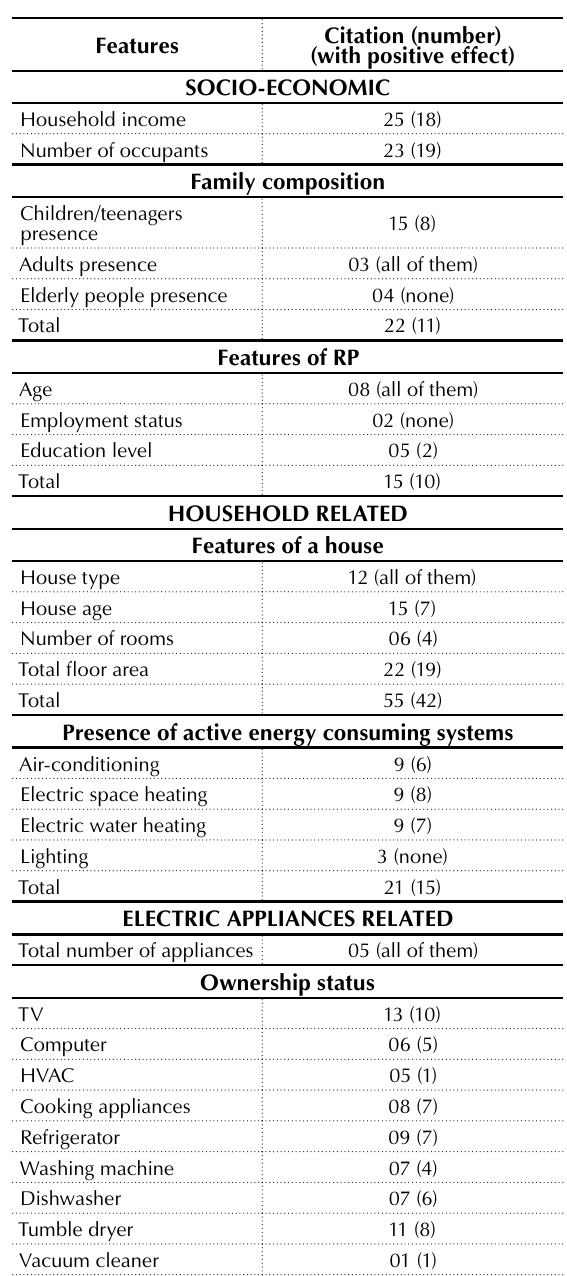
Table 2. Overview of the studies concerning social/economic, households and factors on